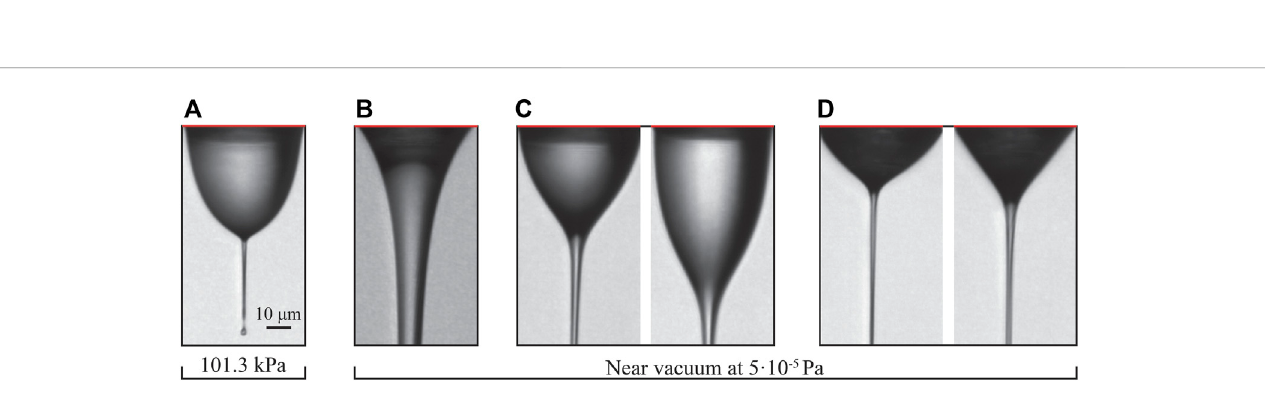
FIGURE 4 TheshapeoftheTaylorconeasafunctionofGFR,SFRandEP.Thefollowingparameters wereused: (A) GFR=9.1 mg/min,SFR=0.25 μ l/min, EP=7 kV, (B) GFR=41.3 mg/min,SFR=12 μ l/min,EP=0 kV,left (C) GFR=15 mg/min,SFR=1 μ l/min,EP=6 kV,right (C) GFR=15 mg/min,SFR=2.5 μ l/min,EP=6 kV, left (D) GFR = 19.2 mg/min, SFR = 0.5 μ l/min, EP = 5 kV, right (D) GFR = 18.9 mg/min, SFR = 1 μ l/min, EP = 6